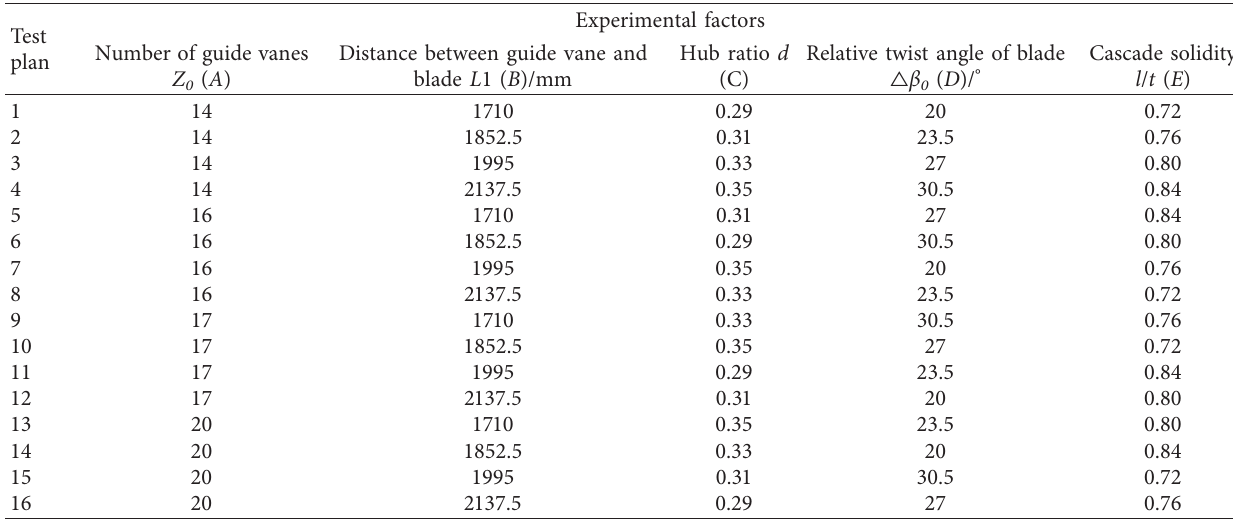
Table 1: Orthogonal test plan.